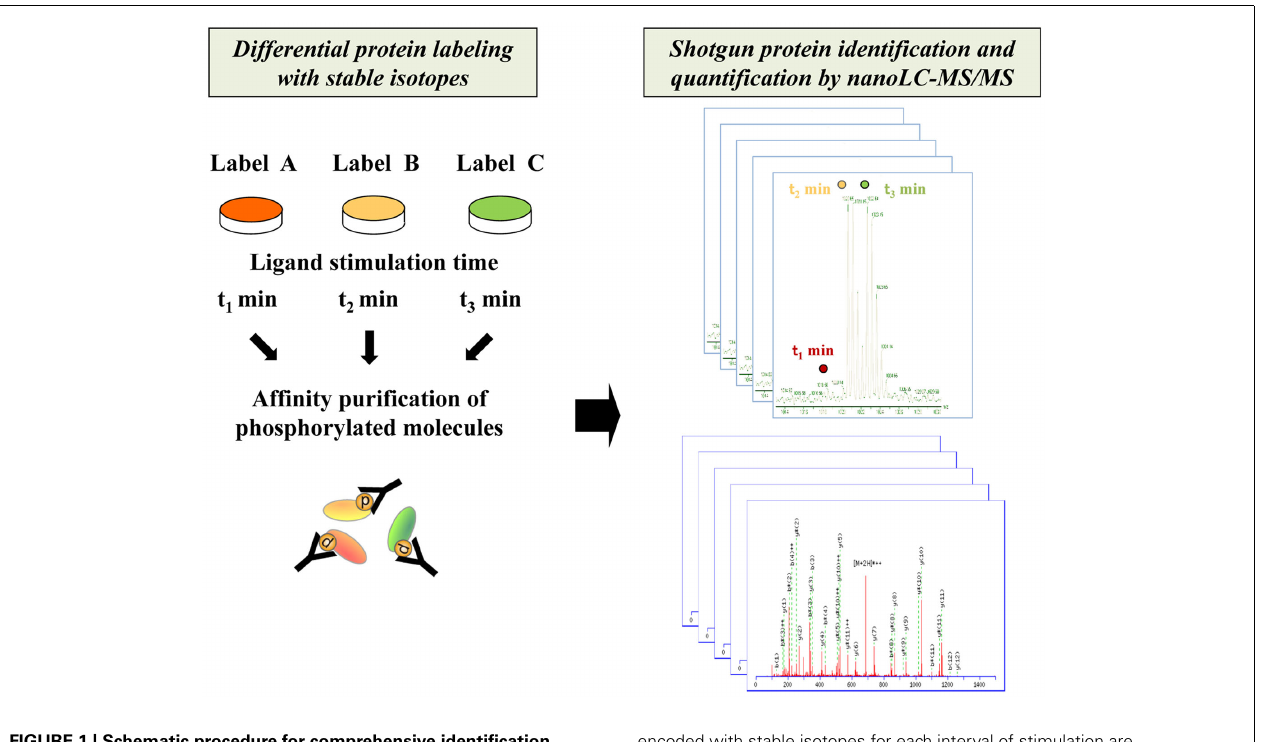
FIGURE 1 | Schematic procedure for comprehensive identification and quantification of phosphorylated proteins by shotgun proteomics technology. The phosphorylated molecules differentially